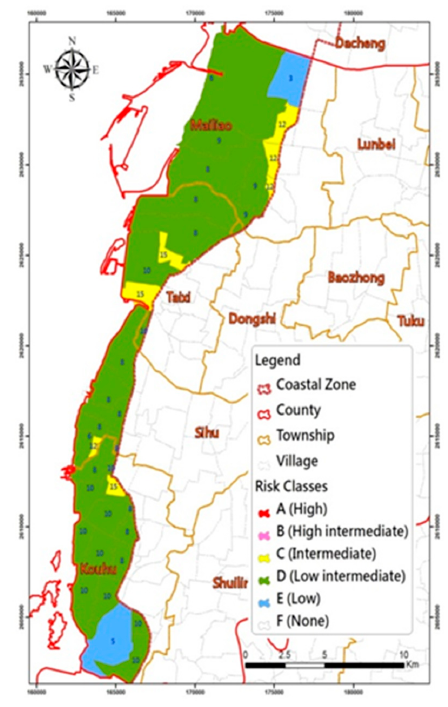
Figure 7. Risk classes of the coastal areas in Yunlin County.